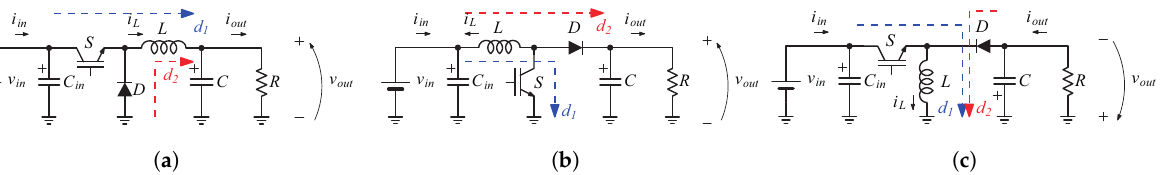
Figure 2. Topologies of three classical dc–dc converters. To improve the readability, the time-dependent parameters ( V in ( t ) , C ( t ) , L ( t ) , i out ( t ) , v out ( t ) and R ( t ) ) appear without ( t ) notation. ( a ); Buck converter. ( b ) Boost converter. ( c ) Buck-Boost